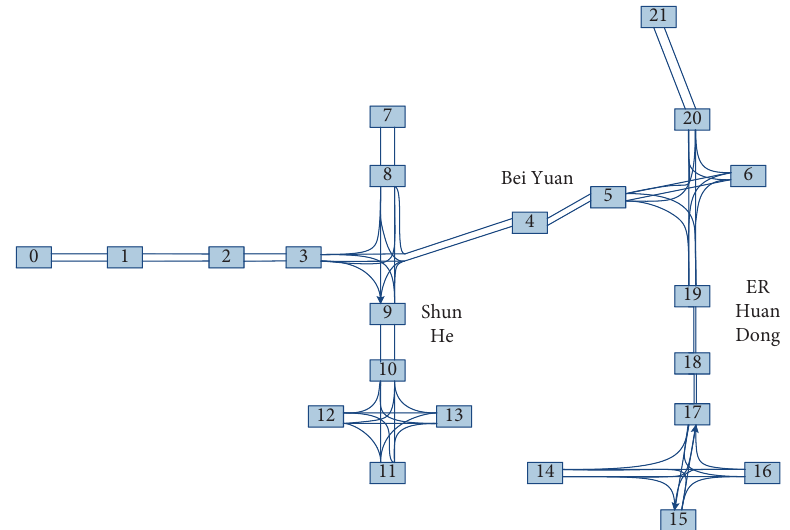
Figure 5: The elevated expressway network of Jinan.